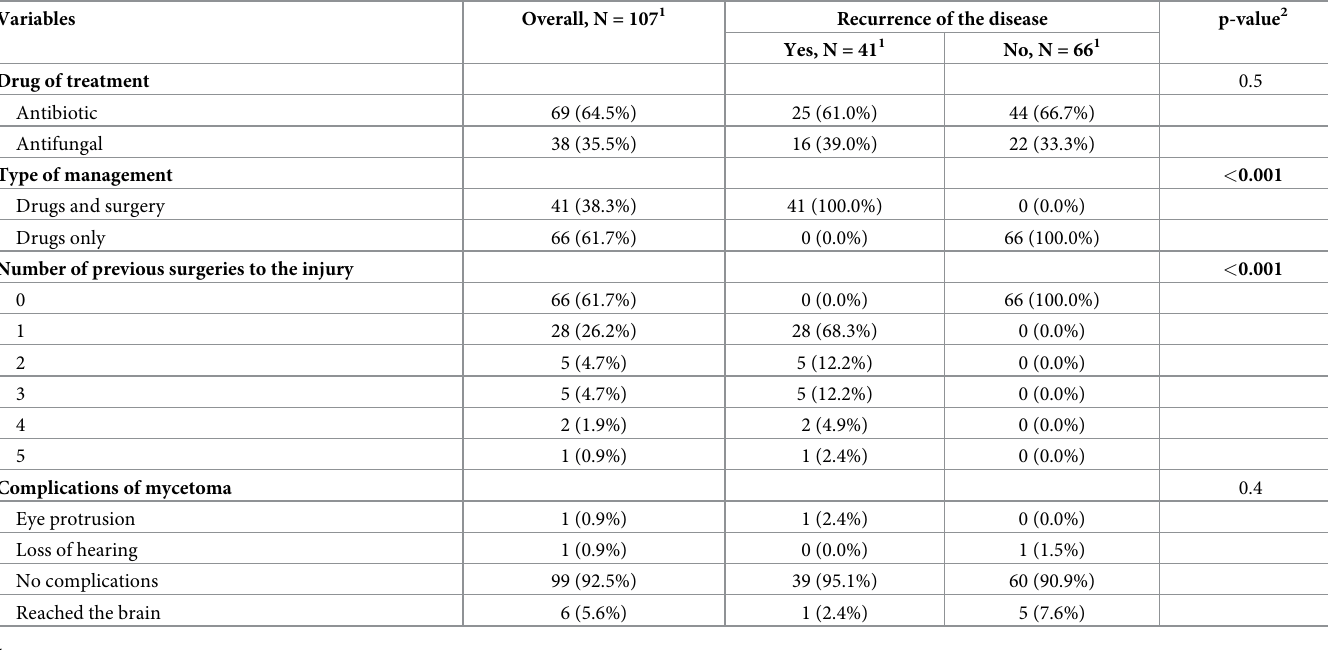
Table 5. Management and complications in patients with head and neck mycetoma. (n =